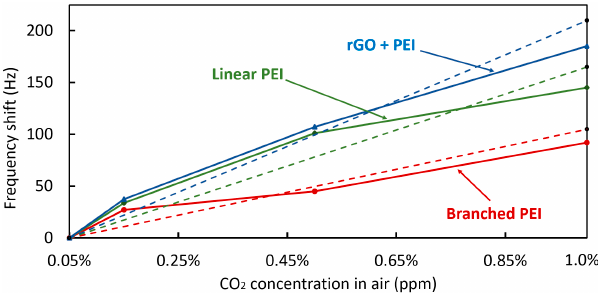
Figure 14. Frequency shift of each coating from 0.05% to 1% of CO 2 .